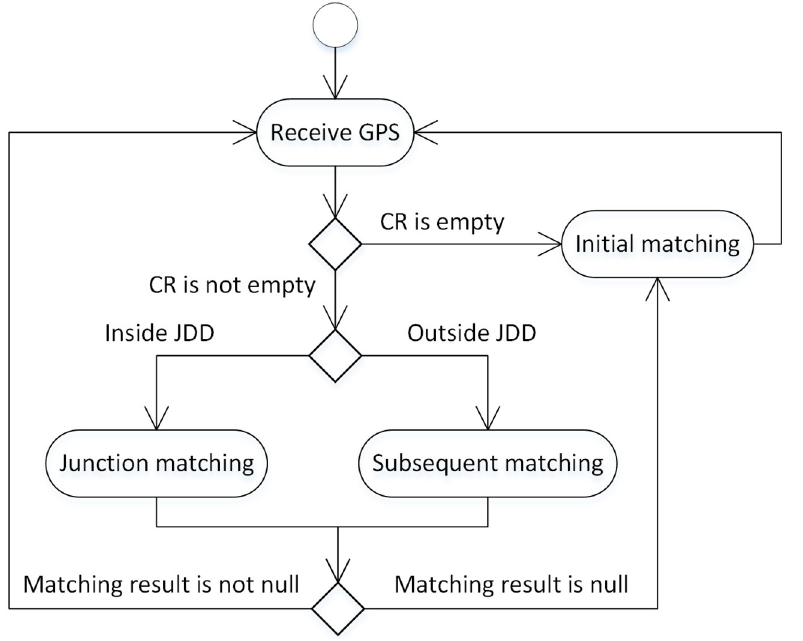
Fig 3. HMM-based matching algorithm using the junction decision